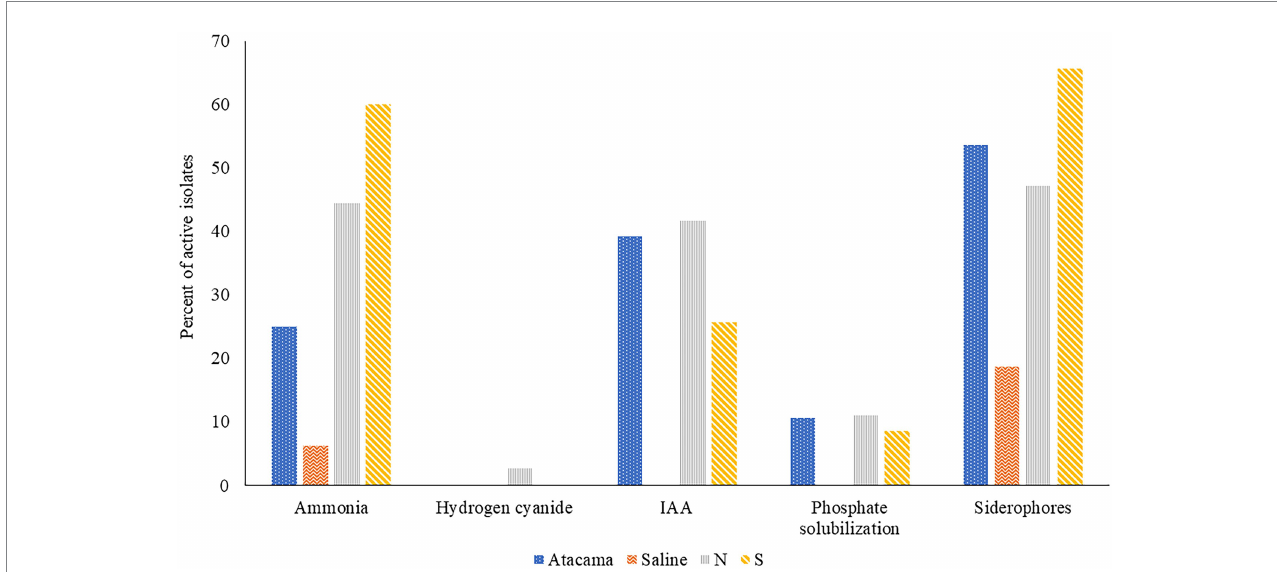
FIGURE 1 Representative isolates [%] from the Atacama Desert, saline and acid forest soil sampling sites which were found to produce compounds that promote plant growth. N and S, isolates from the northern and southern slopes of the inland dunes of the pine